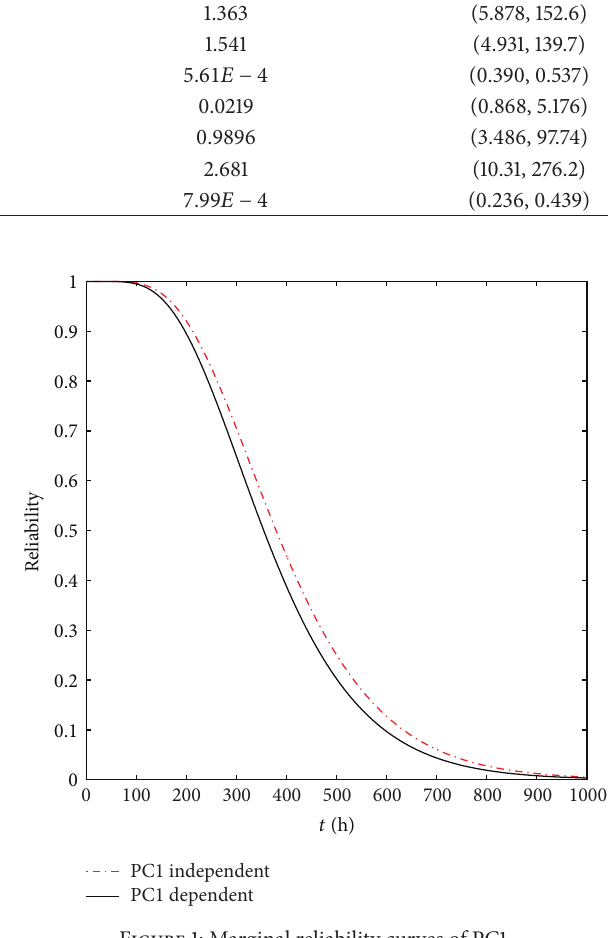
Figure 1: Marginal reliability curves of